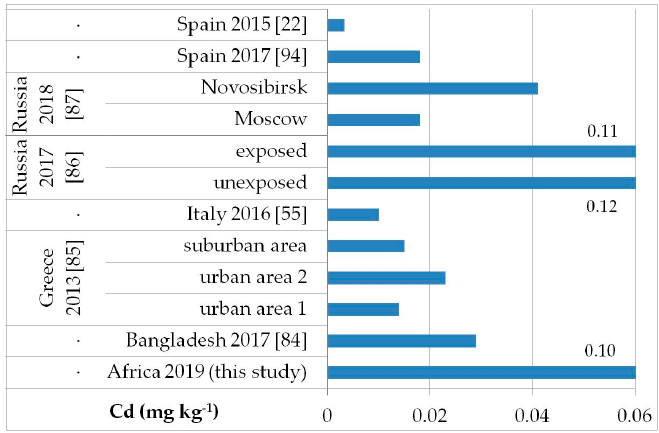
Figure 3. Comparison of the Cd concentrations in children’s hair (as geometric mean; mg kg − 1 ) found in our study and other biomonitoring studies.